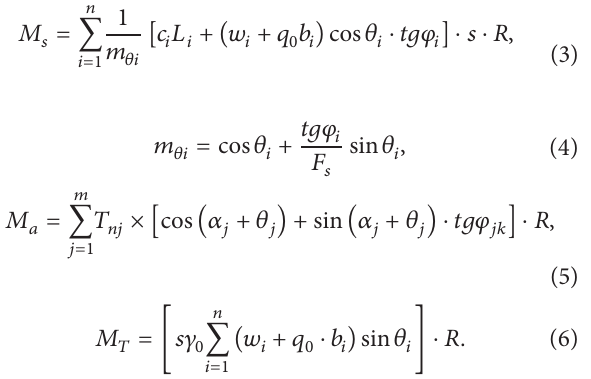
Figure 3: Slip search model of slope reinforced by prestressed